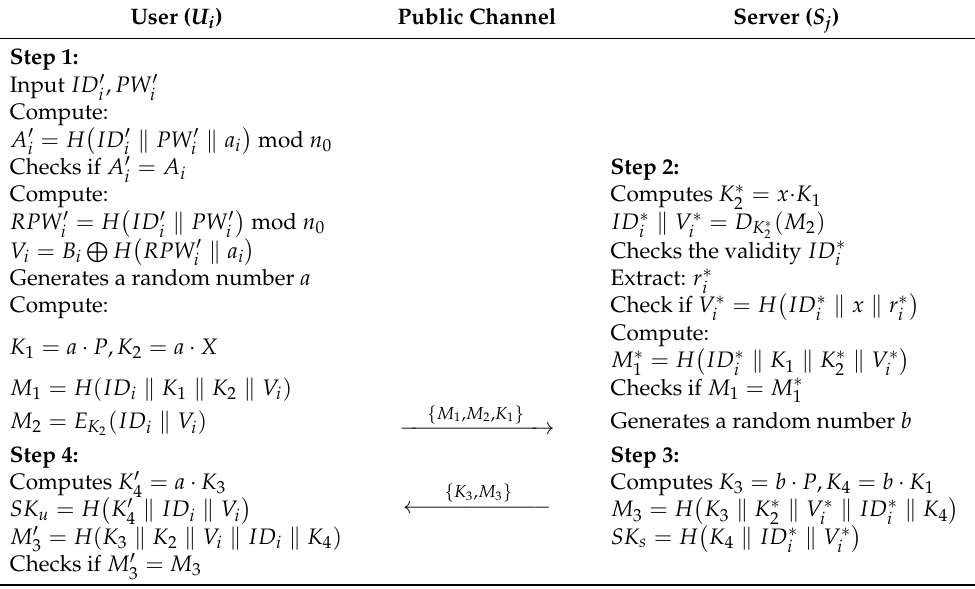
Table 4. Login and authentication